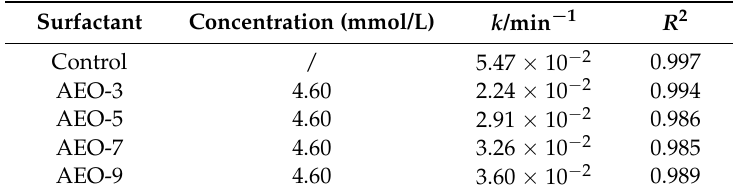
Table 2. Overall reaction rate constants ( k ) for the vinyl sulfone dye and the squares of the correlation coefficients in linear regression ( R 2 ) at different ethylene oxide content in siloxane non-aqueous dyeing system.